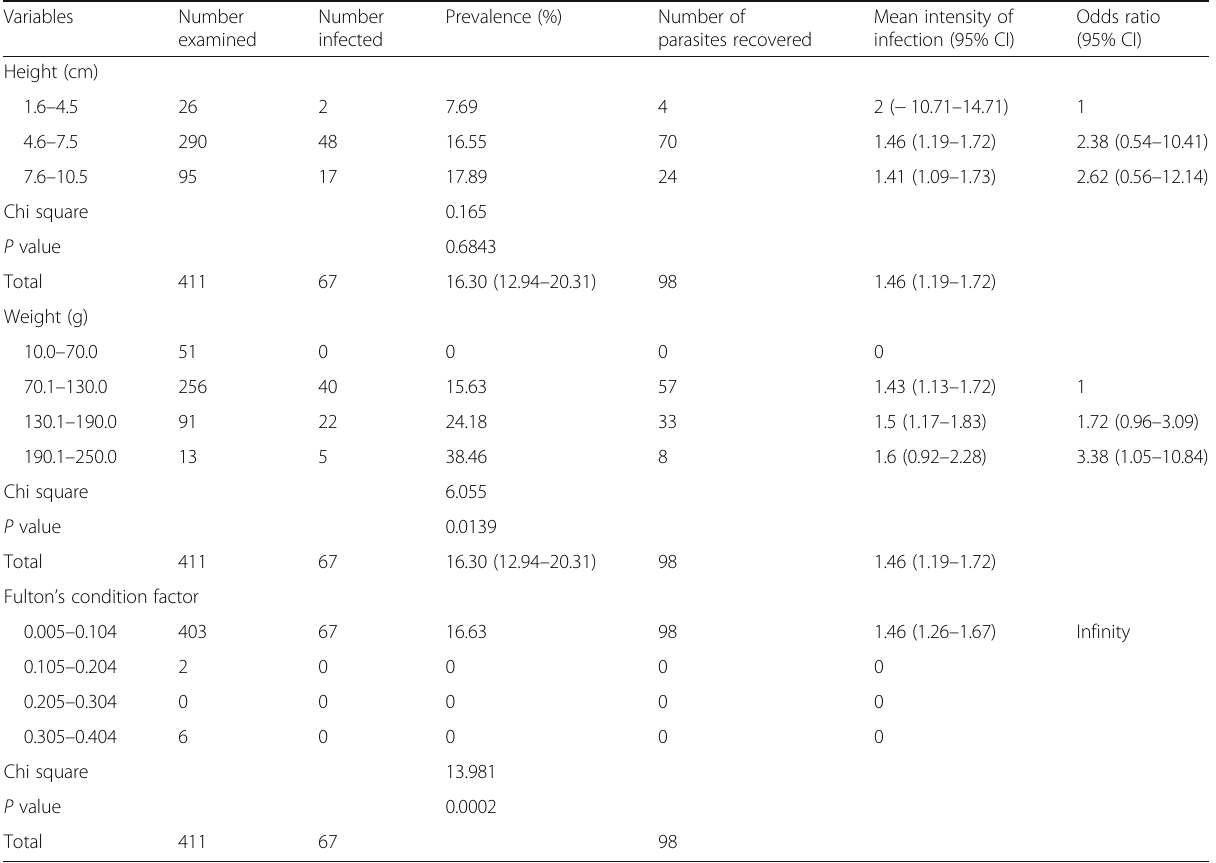
Table 3 Prevalence and intensity of infection by height, weight, and condition